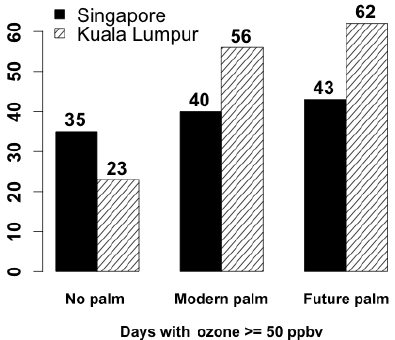
Figure 11. The number of days with simulated daily maximum 8h average surface ozone concentrations exceeding 50ppbv over Sin- gapore and Kuala